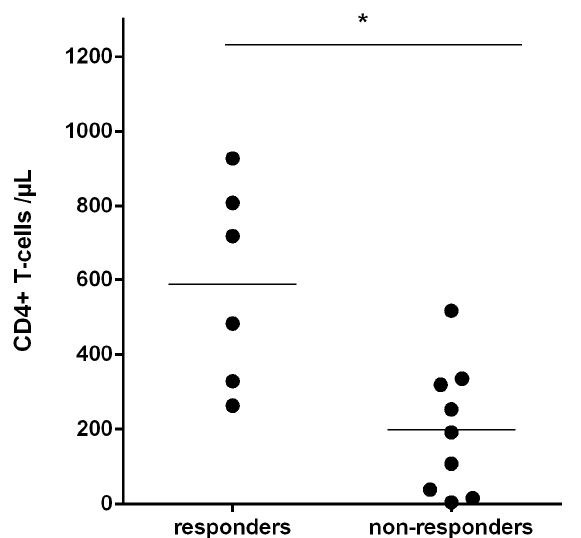
Figure 6. Pre-ART CD4 counts in HLA-B*52+ subjects. HIV-1-infected HLA-B*52+ subjects with de- tection of Rev-RI8-specific T-cells (responders) displayed significantly higher CD4+ T-cells (median 602/µL, range 263–928) than subjects without recognition of Rev-RI8 (non-responders, median